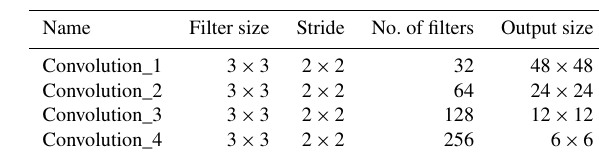
Table 3. Discriminator parameter